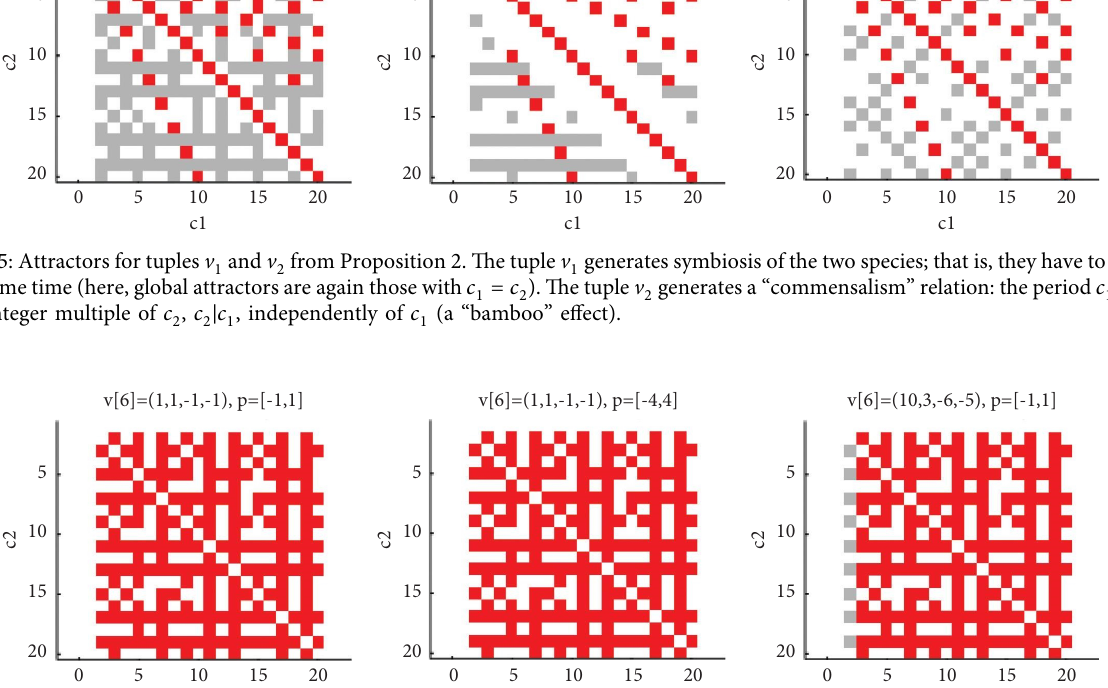
from Proposition 3. Tis is the case of two species, which cannot emerge together—they are mutually 6